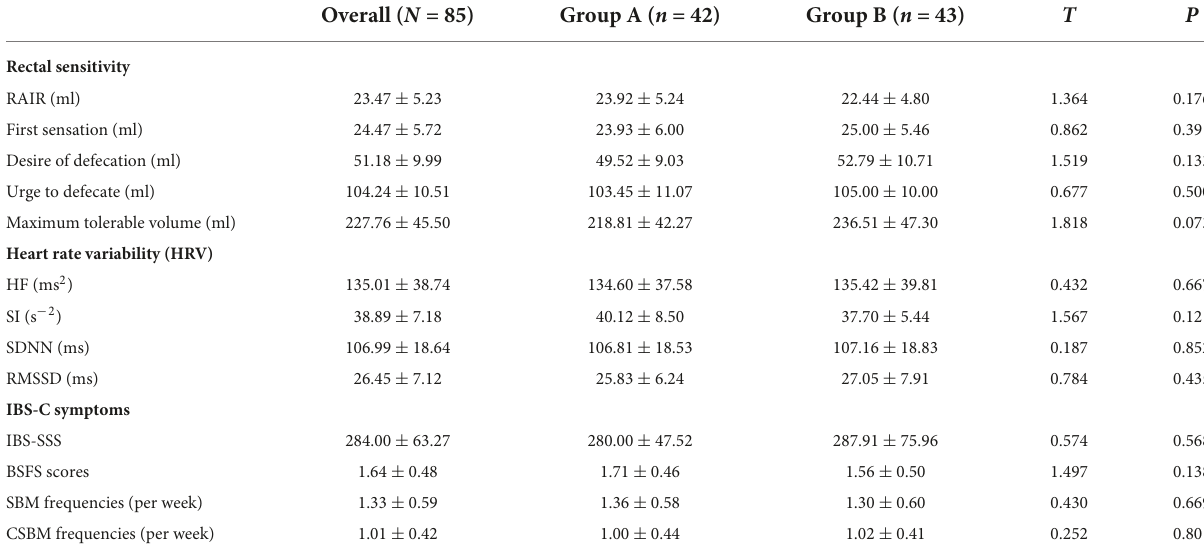
TABLE 2 Baseline characteristics for the two study